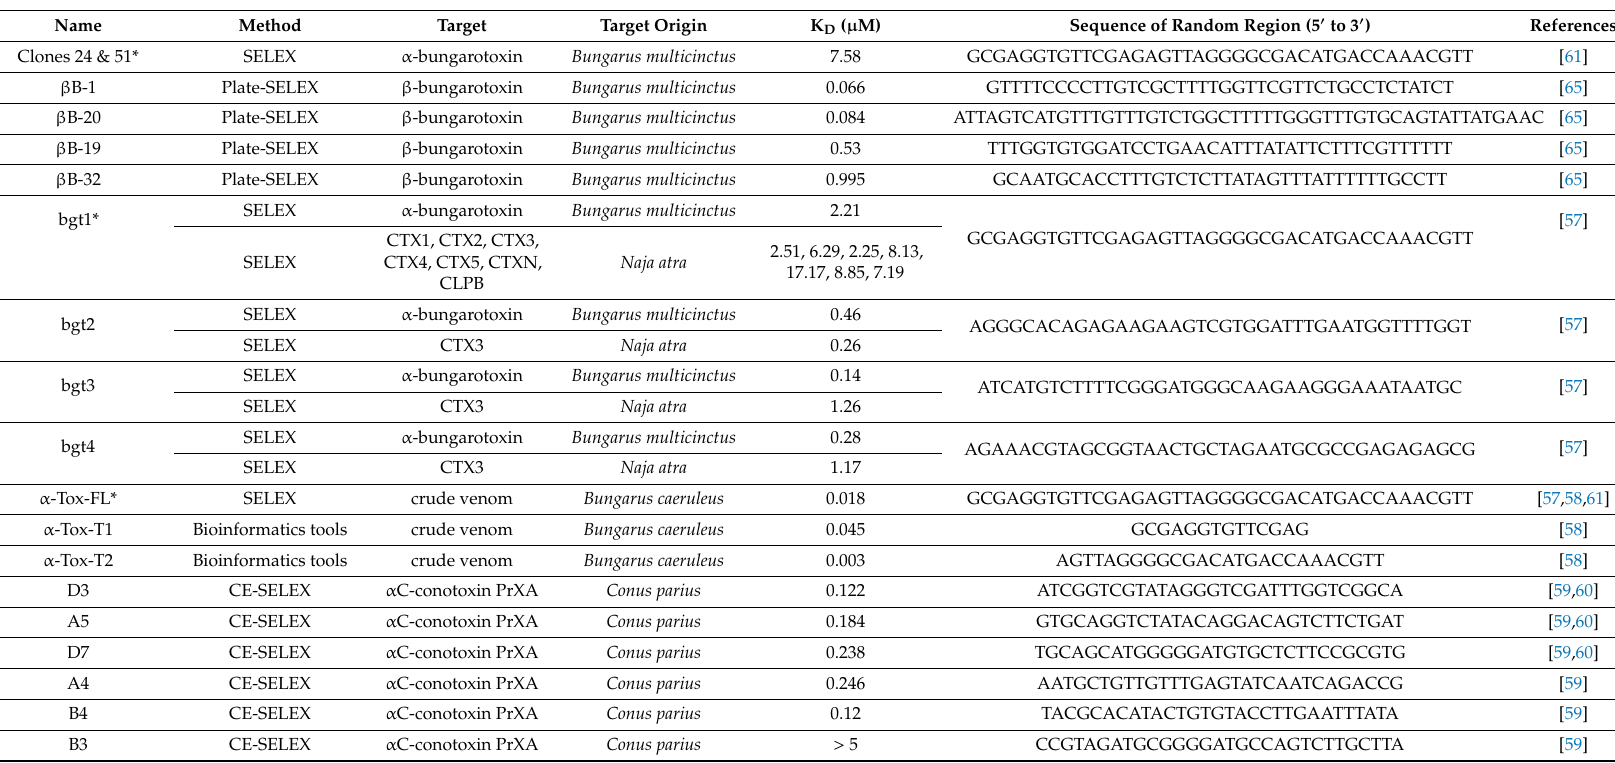
Table 2. List of aptamers developed so far with the aim to neutralize venom toxins. CE: Capillary Electrophoresis; CTX: cardiotoxin; CLPB: cardiotoxin-like protein. All the illustrated aptamers are DNA oligonucleotides. *Aptamers designated bgt1, clones 24 & 51 or α -Tox-FL have identical